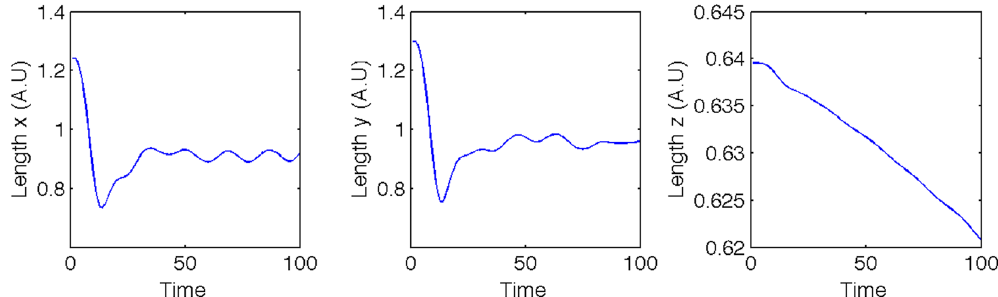
Figure 6. The transverse and longitudinal root-mean-squared beam size of the Diamond micro-bunch in the second plasma stage. The initial transverse size compresses significantly during the first betatron oscillation before undergoing smaller amplitude oscillations. The length of the micro-bunch decreases throughout the simulation as the head of the bunch experiences the decelerating regions of the wakefield and the rear the